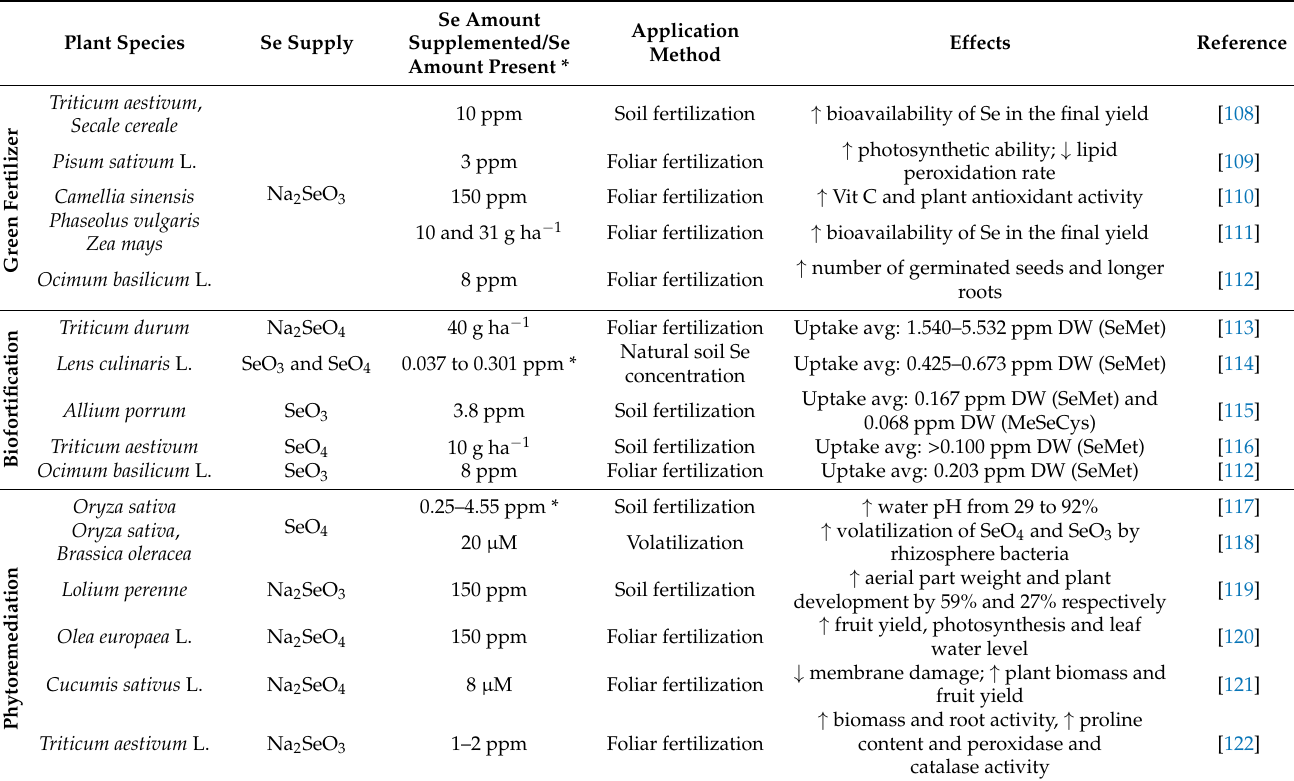
Table 2. Selenium (Se) contribution towards sustainable agriculture